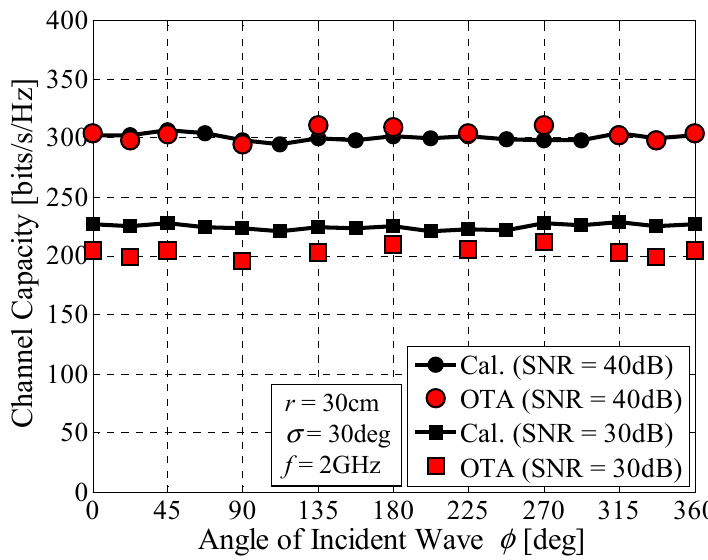
Figure 23. Channel capacity of a 32 × 32 MIMO array antenna measured by OTA testing.